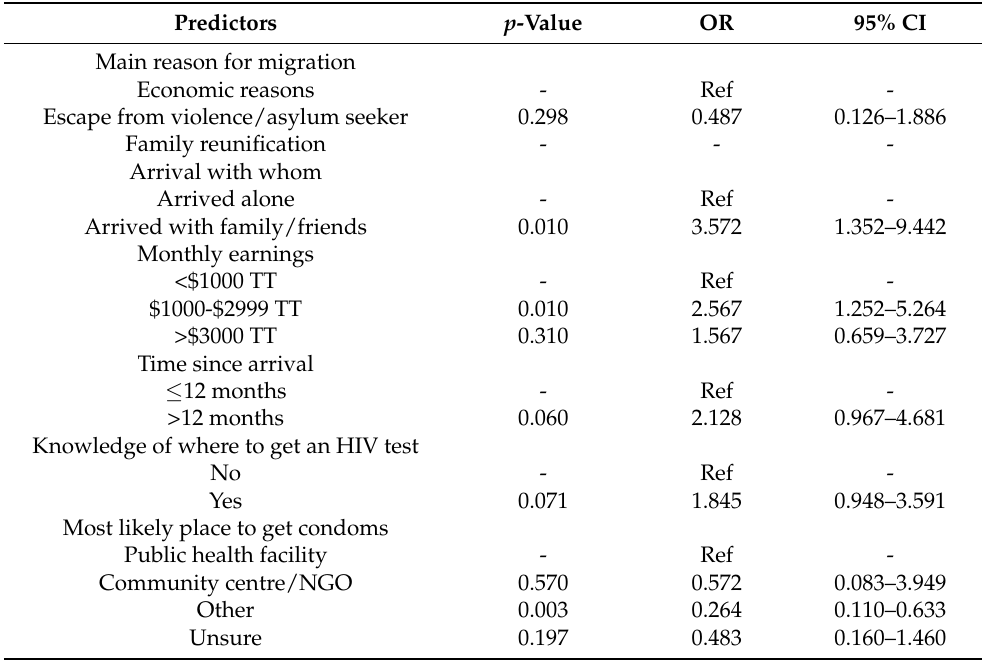
Table 6. Correlates of having trouble accessing public health services while in